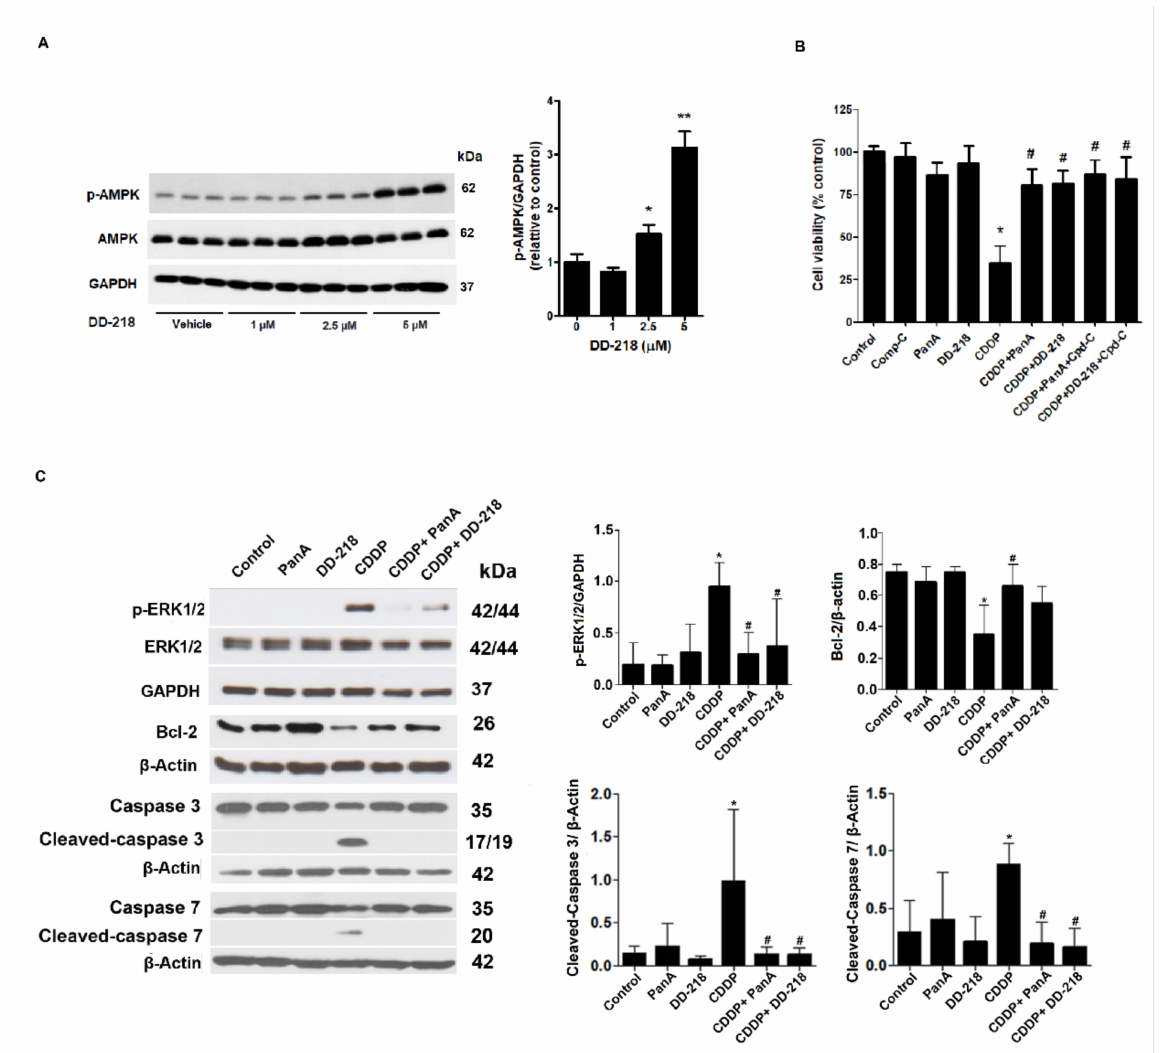
Figure 4. ( A ) Effect of DD-218 on AMPK expression. RPTEC/TERT1 cells were incubated for 24 h with 0.1% DMSO and DD- 218 (1, 2.5, and 5 µ M). ( B ) Effect of AMPK inhibitor on the protective of panduratin A (PanA) and DD-218. RPTEC/TERT1 cells were incubated with: 0.1% DMSO (control); 10 µ M compound (Comp-C); 5 µ M PanA; 5 µ M DD-218; 50 µ M CDDP; combinations as indicated. ( C ) Effects of PanA and DD-218 on expression of p-ERK1/2, Bcl-2, and cleaved-caspase 3 and cleaved-caspase 7 in renal tubular cells. RPTEC/TERT1 cells were incubated for 24 h with: 0.1% DMSO (control); 5 µ M PanA; 5 µ M DD-218; 50 µ M CDDP in the presence of 5 µ M PanA (CDDP+PanA); 50 µ M CDDP in the presence of 5 µ M DD-218 (CDDP+DD-218). Values are shown as mean ± SD of at least 3 independent experiments: * p < 0.05 compared to control, ** p < 0.01; # p < 0.05 compared to CDDP